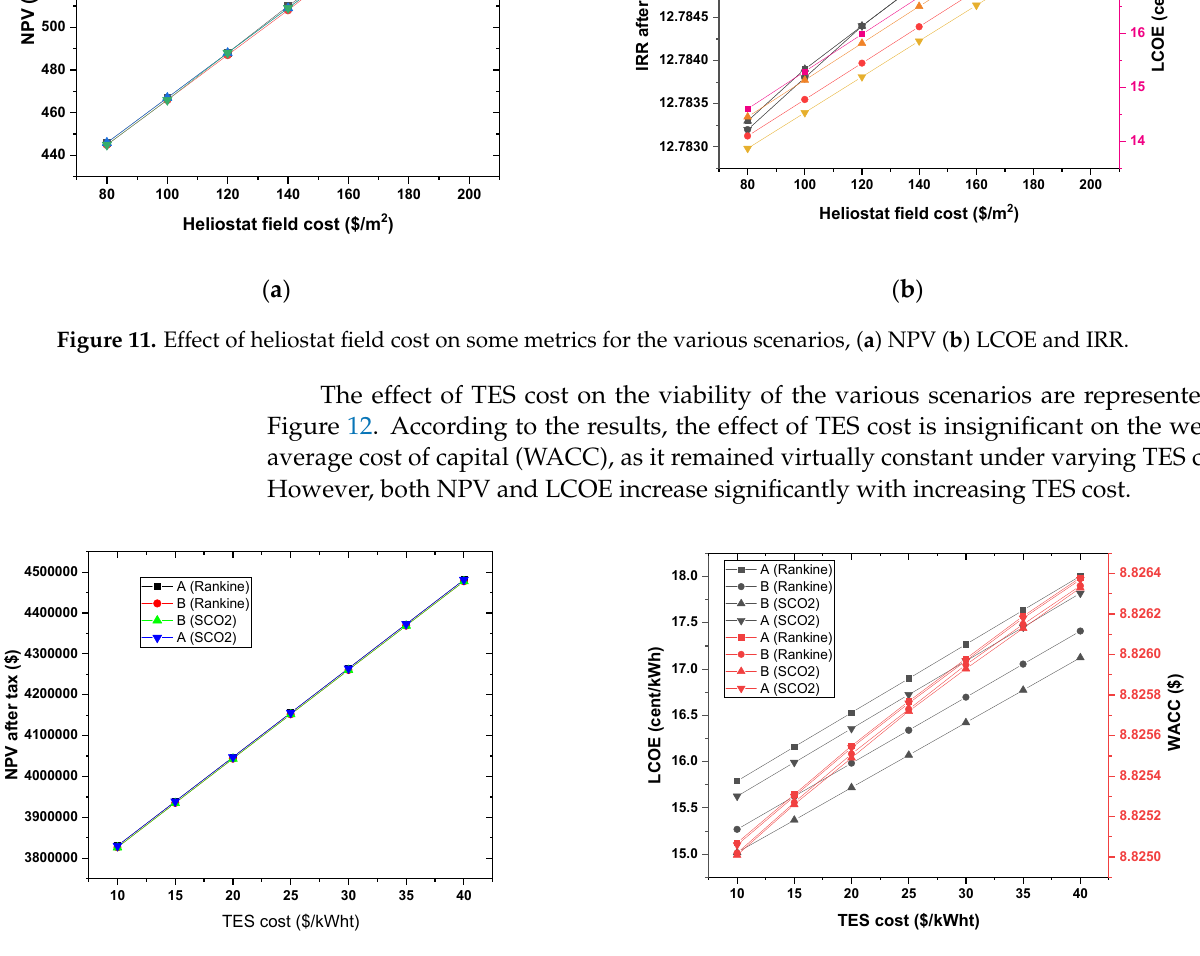
Figure 12. Effect of TES on some economic metrics for the various scenarios.